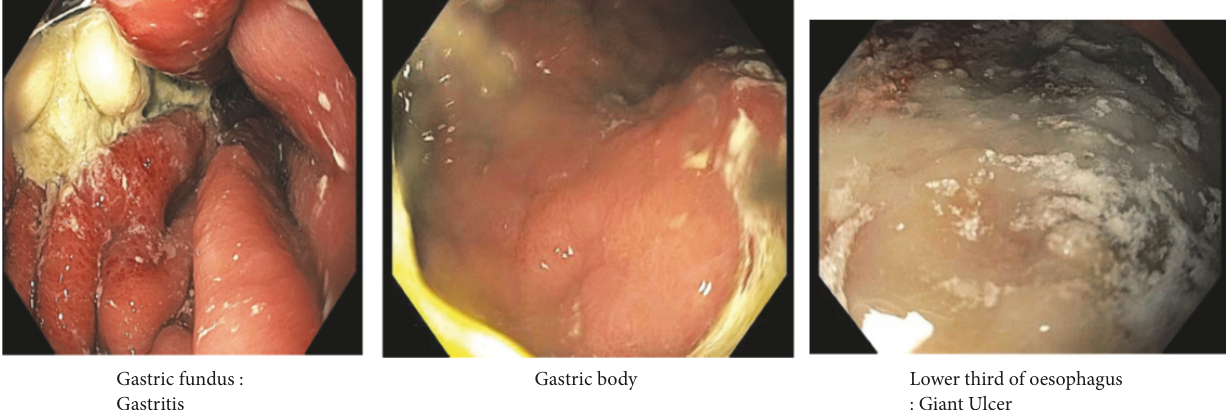
Figure 3: Endoscopy images showing nonbleeding erosive gastropathy, erythematous mucosa in the gastric body and antrum, esophagitis, and nonbleeding esophageal ulcer (7th day of